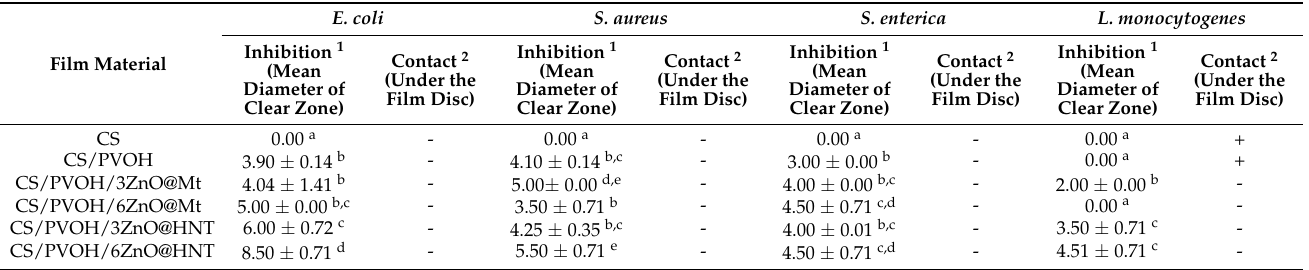
Table 5. Antimicrobial activity of active films against food pathogenic bacteria E. coli , S. aureus , S. enterica , and L. monocytogenes